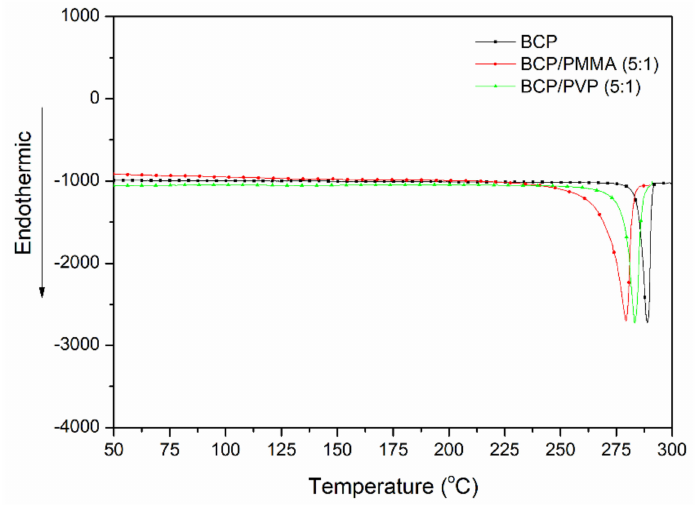
Figure 3. DSC (differential scanning calorimetry) thermograms of BCP, BCP/PMMA (5:1, w / w ), and BCP/PVP (5:1, w / w